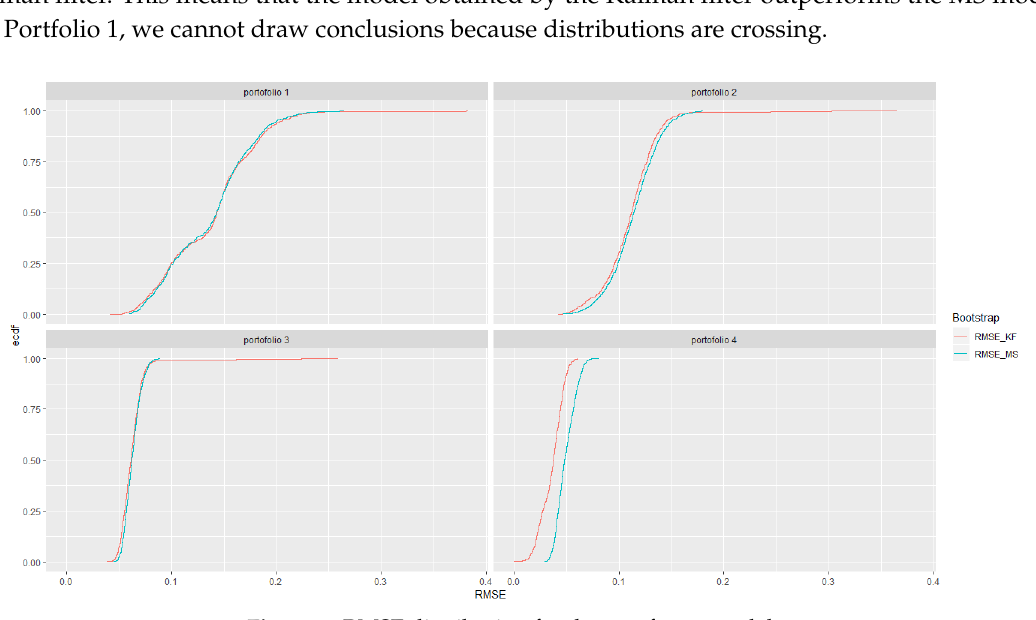
Figure 3. RMSE distribution for the one-factor